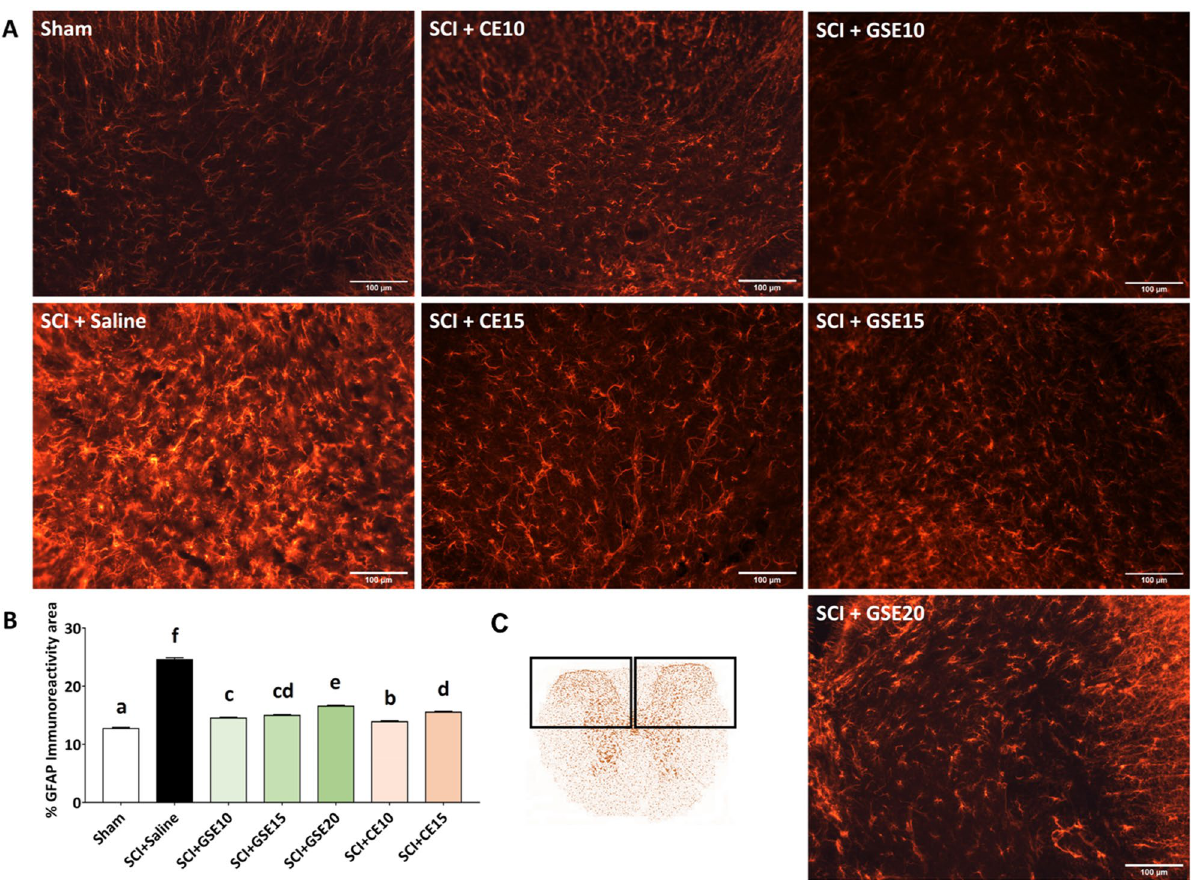
Figure 4. Effects of GSE and CE treatment on the spinal GFAP immunoreactivity area in SCI mice at the end of the experimental period . ( A ) Representative histological images of the spinal cord immunostained against GFAP of each group (scale bar 100 μm). ( B ) Histograms representing the percentage of dorsal horn GFAP immunoreactivity. ( C ) Schematic representation of spinal cord section showing where images capture and immunohistochemical analysis were performed. Data are expressed as the mean ± SEM. a–f: Groups not sharing a letter showed significant differences, p < 0.05. Experimental groups: Sham (n = 4; slices = 60), SCI + Saline (n = 4; slices = 62), SCI + GSE10 (n = 4; slices = 68), SCI + GSE15 (n = 5; slices = 84), SCI + GSE20 (n = 5; slices = 54), SCI + CE10 (n = 5; slices = 58), SCI + CE15 (n = 4; slices =